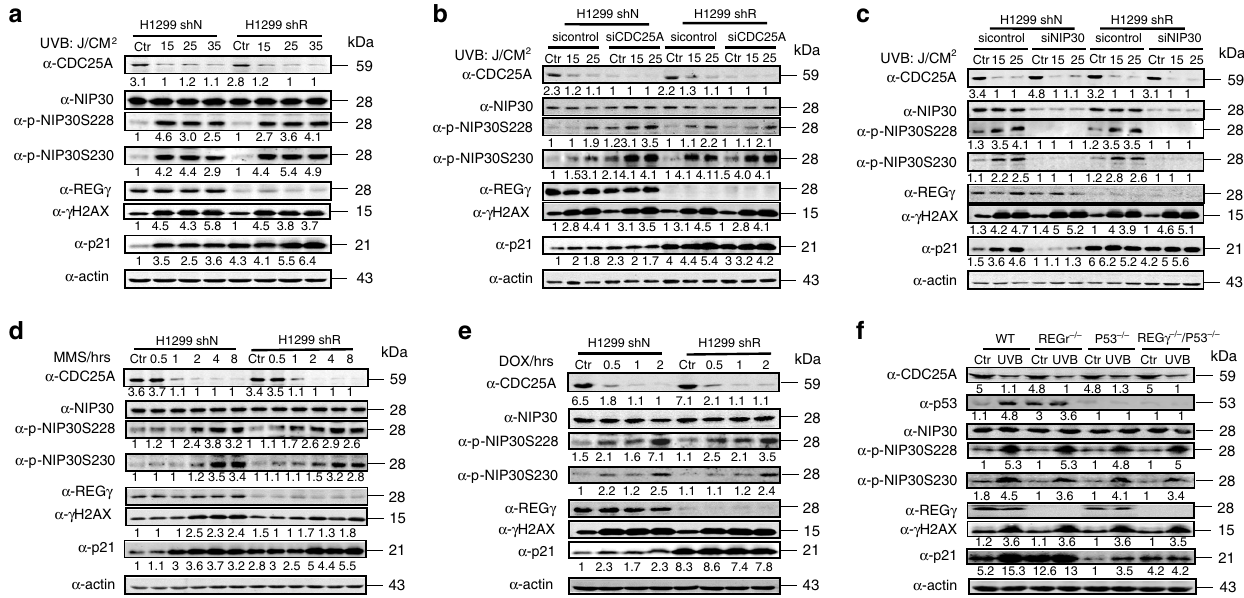
Fig. 5 The CDC25A – NIP30-REG γ pathway controls p21 following DNA damage. a H1299 REG γ shN and shR cells were irradiated with 0, 15, 25, or 35 J/ m 2 UVB and harvested 12 h later. Cell lysates were analyzed by western blots with indicated antibodies. b H1299 REG γ shN and shR cells were treated with siRNA against CDC25A or a control siRNA followed by UVB irradiation. Cell lysates were subjected to western blot with indicated antibodies. c H1299 REG γ shN and shR cells were treated with siRNA against NIP30 or a control siRNA followed by UVB irradiation. Cell lysates were subjected to western blot with indicated antibodies. d , e CDC25A – NIP30 action after DNA damage by chemical reagents. H1299 REG γ shN and shR cells were treated with 0.2 mM MMS ( d ) or 10 μ g/ml Doxorubicin ( e ) for the indicated time course. The levels of CDC25A, total NIP30, pNIP30Ser228, pNIP30Ser230, p21, REG γ , and γ H2AX were determined by western blot. f In vivo action of the CDC25A – NIP30-REG γ pathway. REG γ + / + , REG γ − / − , P53 − / − , and REG γ − / − /P53 − / − newborn mice were exposed to UV light as described in “ Methods ” . Skin samples from exposed dorsal side or ventral side (un-exposed control) were examined for proteins indicated. All the experiments were repeated three times. Source data are provided in a Source Data fi